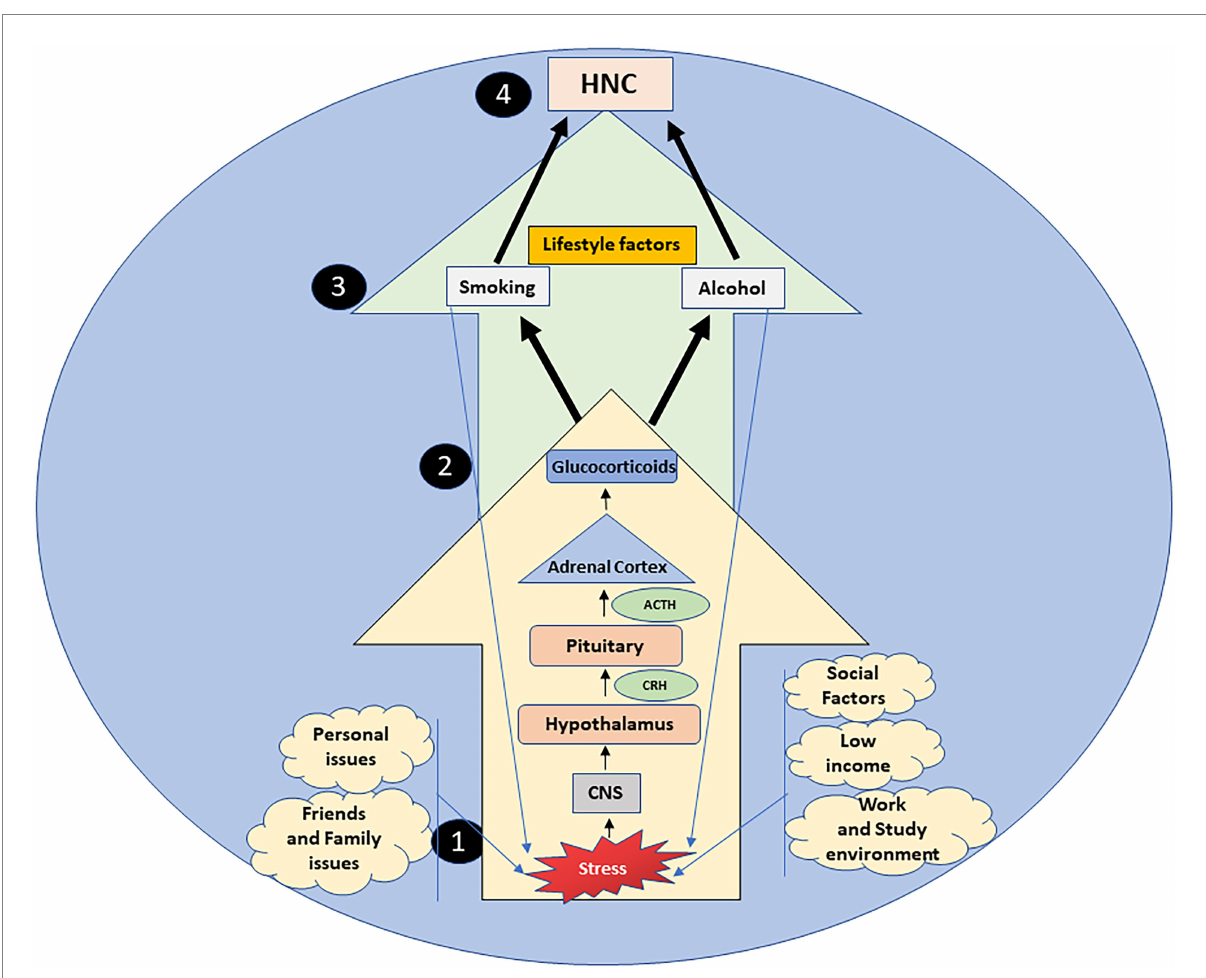
FIGURE 1 Stress, a constant aspect of everyday life, is a serious upstream reason in the adoption and continuation of alcohol consumption and smoking via the HPA axis. Stressful situations arising from multiple stressors (1), are processed by the central nervous system (CNS), that activates the hypothalamus pituitary adrenal (HPA) axis (2). The hypothalamus, pituitary gland and adrenal cortex cause the sequential release of corticotropin- releasing hormone (CRH), adrenocorticotropin releasing hormone (ACTH) and glucocorticoids respectively (2). Prolonged exposure to stress can increase the burden of glucocorticoids, enhancing the vulnerability to lifestyle risk factors (alcohol and smoking) (3), that initially act as anxiolytics, yet simultaneously as stressors, increasing the HPA axis activity. Thus, stress through the deregulated HPA axis acts as an upstream factor in the lifestyle risk etiology of head and neck cancers (HNC)